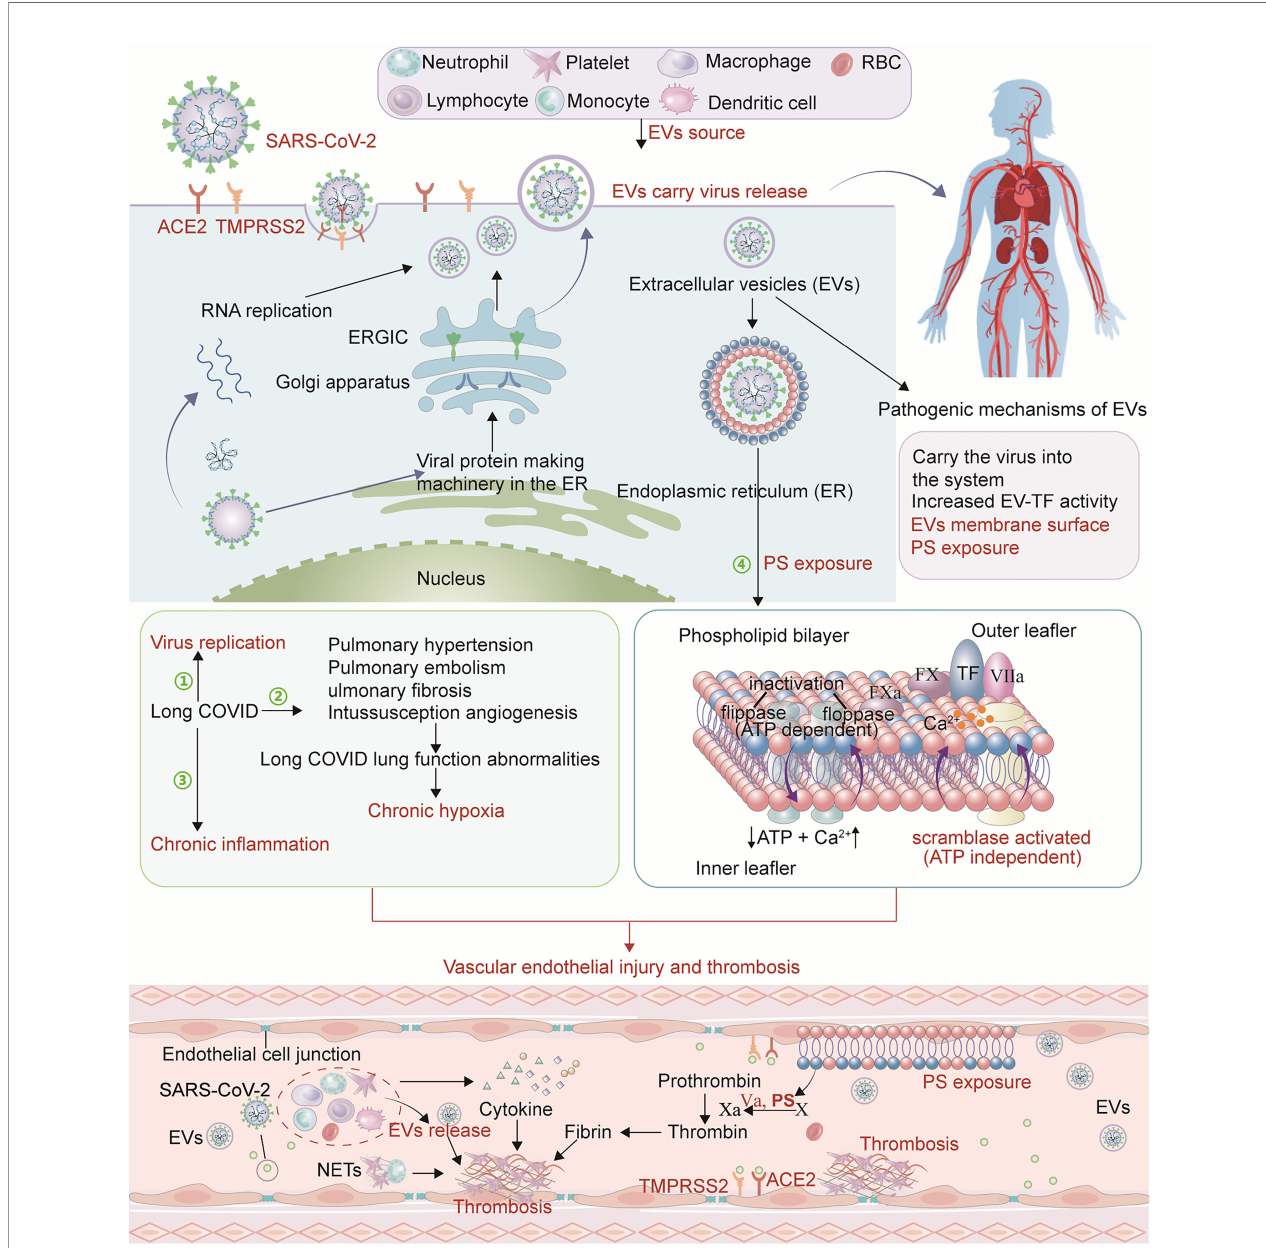
FIGURE 1 | Pathophysiological mechanism of long COVID thrombosis. SARS-CoV-2 enters cells through ACE2 and TMPRSS2 receptors and conducts RNA and protein synthesis and replication. SARS-CoV-2 buds in the ERGIC compartment or Golgi apparatus and exits the cell via a biosynthetic secretory pathway. In long-COVID, SARS-CoV-2 may hide in these EVs and re-attack various tissues and organs through the circulatory system. In addition, PS exposure on EVs creates a catalytic surface for clotting factors to facilitate the conversion of prothrombin to thrombin. After cell activation and injury, ATP production is reduced and consumption increases. With the resulting increase in intracellular Ca 2+ , two ATP-dependent transposases ( fl ippase and fl oppase) are blocked, and ATP- independent scramblases are activated. This leads to the exposure of PS in the outer cell membrane, accompanied by the shedding of microparticles (MPs). PS promotes the decryption of tissue factor (TF) to form TF-FVIIa complex and provides binding sites for procoagulant complexes (endogenous and exogenous fXase and prothrombinase) leading to the generation of thrombin. Pulmonary hypertension, pulmonary embolism and pulmonary fi brosis are common in long COVID resulting in impaired lung function. With the change of lung function, chronic hypoxia inevitably occurs. Hypoxia-induced in fl ammation may further exacerbate capillary dysfunction and promote thrombosis. Due to SARS-CoV-2 persistence, chronic in fl ammation in long COVID may be a mechanism that stimulates ECs, platelets and other in fl ammatory cells, promotes the upregulation of procoagulant factors, and destroys the protective function of vascular endothelium, thereby causing abnormal